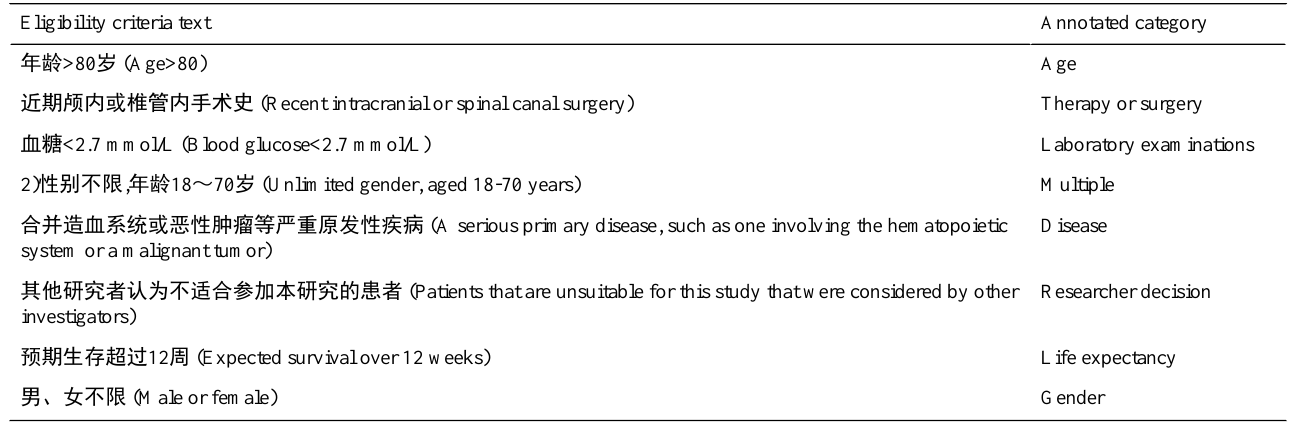
Table 1. Examples of eligibility criteria texts and corresponding annotated categories.